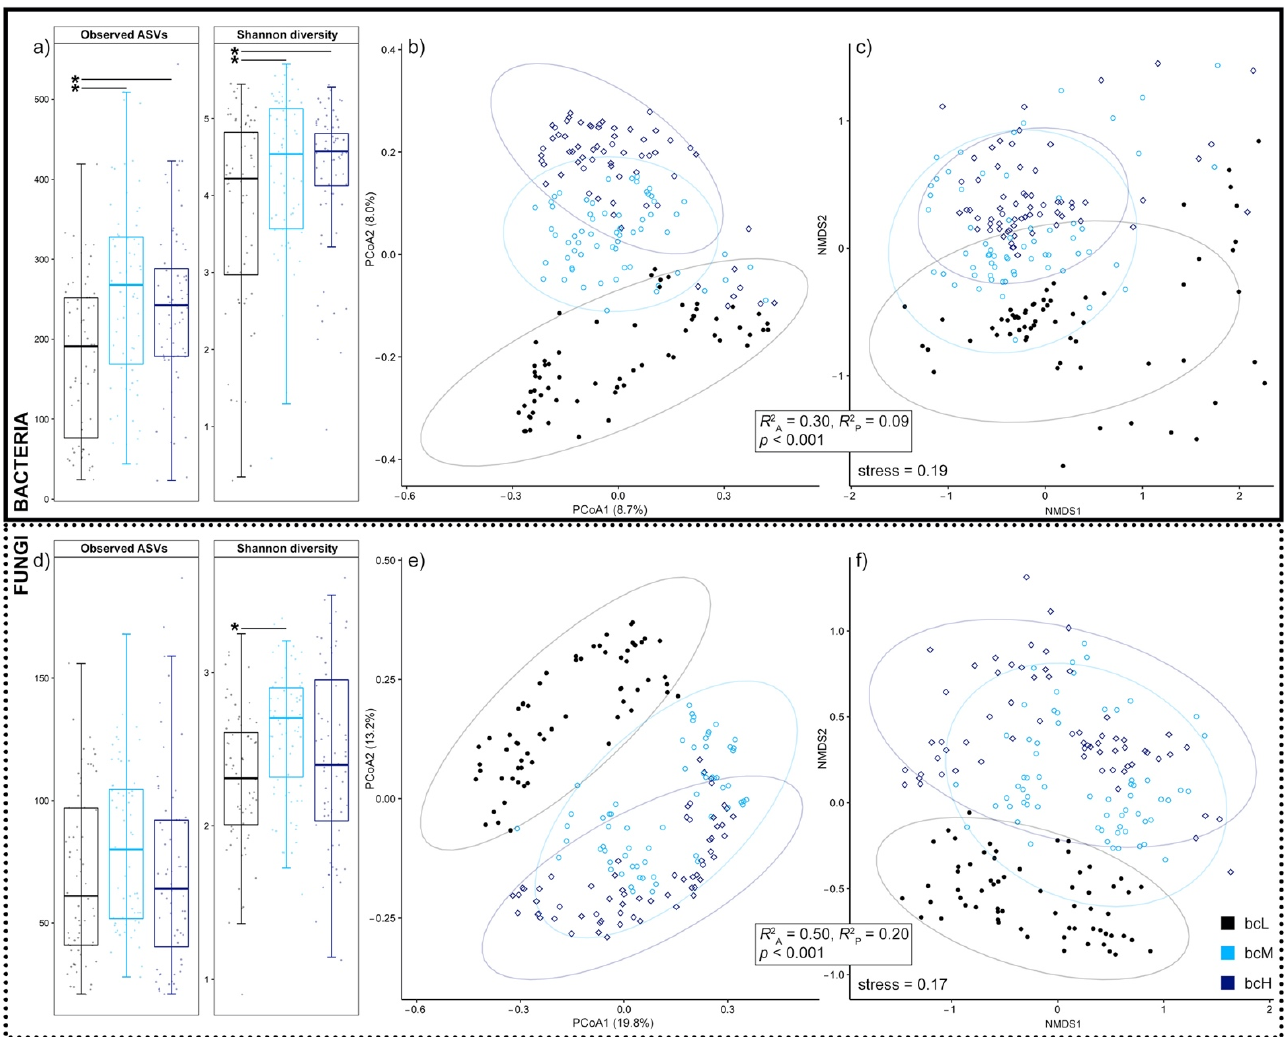
Figure 2. Phylloplane black carbon load correlates with bacterial and fungal diversity . Bacterial ( n = 190) and fungal ( n = 192) intra-sample (alpha) diversity was assessed with amplicon sequence variant (ASV) observations and by calculating Shannon diversity indices ( a , d ). Box plots span the interquartile range (25th to 75th percentile), lines within boxes denote the median, and whiskers extend to 1.5 times the interquartile range. Multiple t -test significance ( p < 0.05) is indicated with an asterisk (*). Inter-sample (beta) diversity was measured with principal coordinate analysis (PCoA; b , e ) and nonmetric multidimensional scaling (NMDS; c , f ) on Bray–Curtis dissimilarity matrices. Ellipses indicate 95% data intervals. ANOSIM ( R 2A ) and PERMANOVA ( R 2P ) effect size and significance are shown. Low (bcL), medium (bcM), and high (bcH) phylloplane BC load.